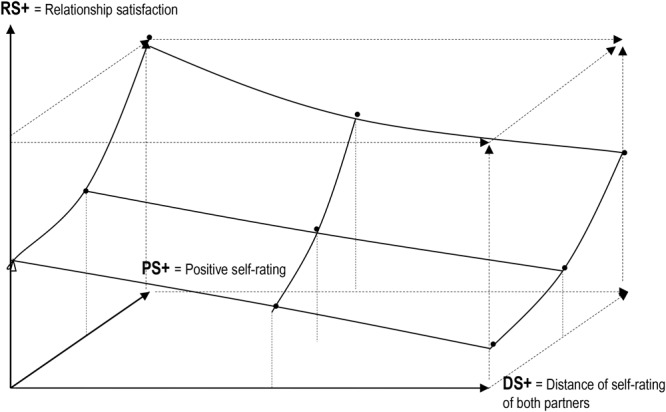
Theoretical model of relationship satisfaction (RS) as function of distance of self-rating of both partners (DS) (monotonically decreasing) and Positive self-rating (PS) (monotonically increasing). Based on this model, RS is high (low), if PS is high (low), and RS is low (high), if DS is high (low). Disturbing of clear relation is a negative correlation between PS and DS and possibly further suppressor effects of other variables as socio-economic status, health, interests, partnership model (culture) etc.